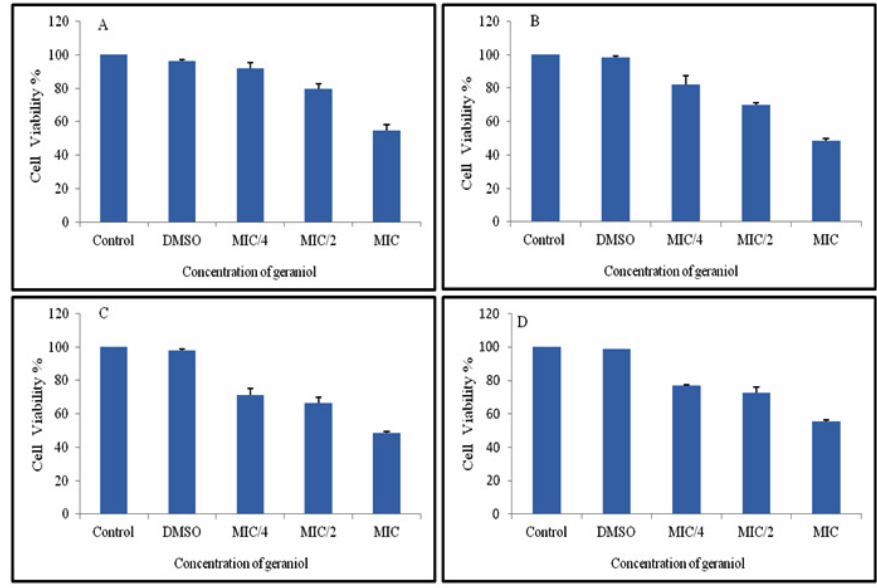
Fig. 7. Effect of varying concentrations of geraniol (MIC, ½ MIC, ¼ MIC) on adhesion in C. albicans ATCC 90028 (A), C. albicans ATCC 10261 (B), C. albicans FLC sensitive D-27 (C) and FLC resistant C. albicans S-1(D ). Cell viability was estimated using the XTT reduction assay after 1 h incubation. 1% DMSO was also used as a